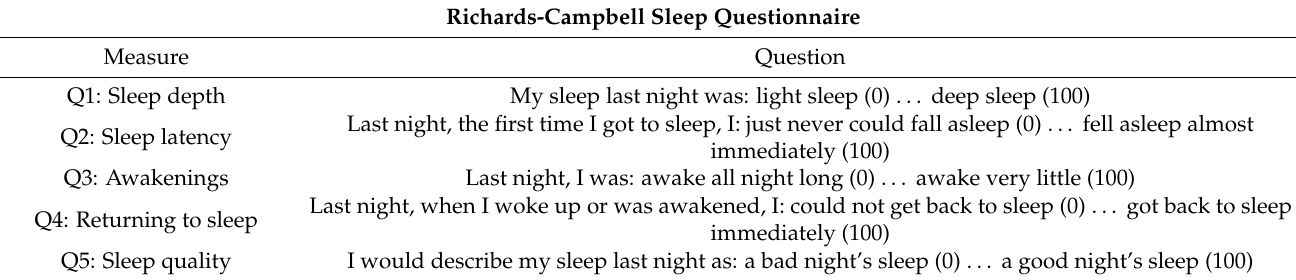
Table 1. The Richards-Campbell Sleep Questionnaire. Richards-Campbell Sleep